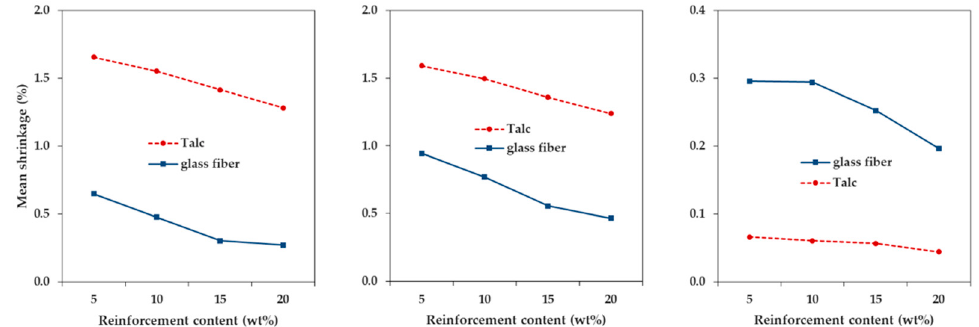
Figure 16. Main effect plot for differential shrinkage.